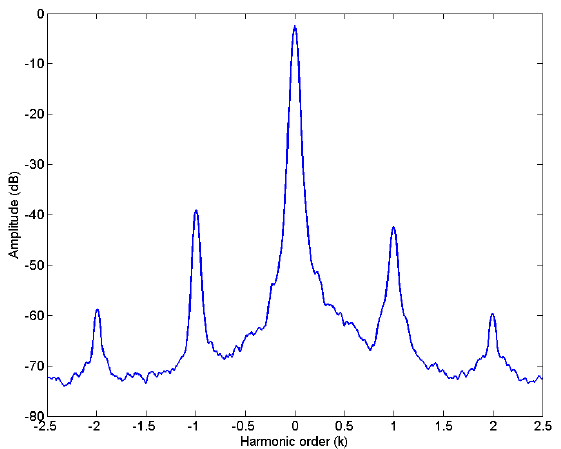
Figure 2. Final result vector in harmonic k -order domain obtained with HOTA